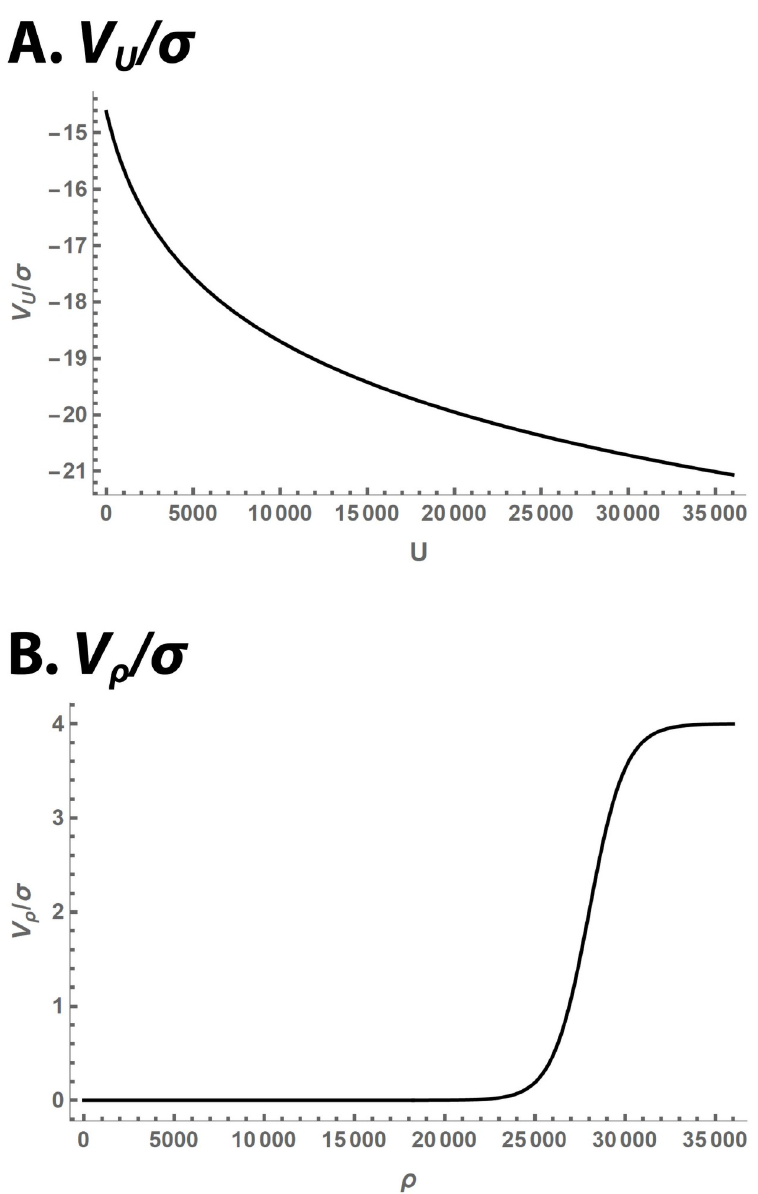
Fig 1. Potential function plots. Potential functions that appear in the ρ PDE (2). Both potentials are made dimensionless by dividing them by σ . Parameter values are as in Table